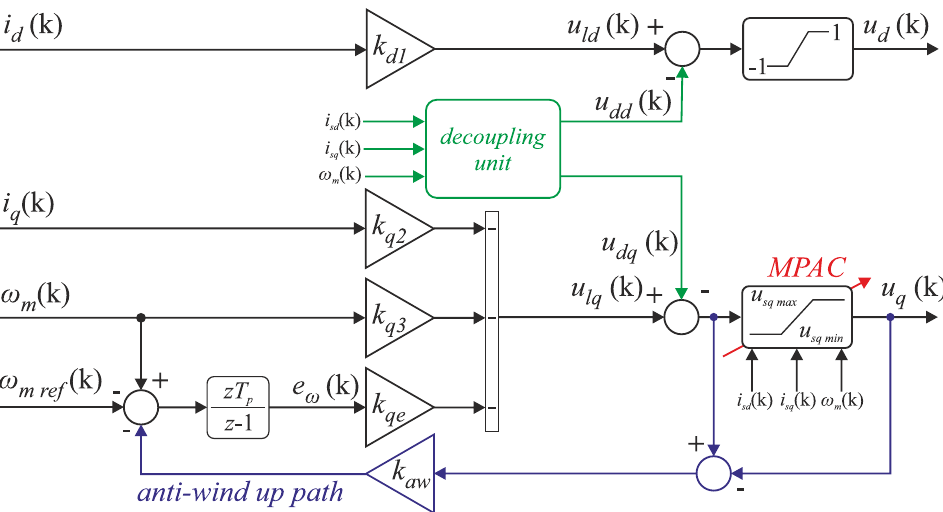
Figure 1. Block diagram of the SFC with MPAC, decoupling and